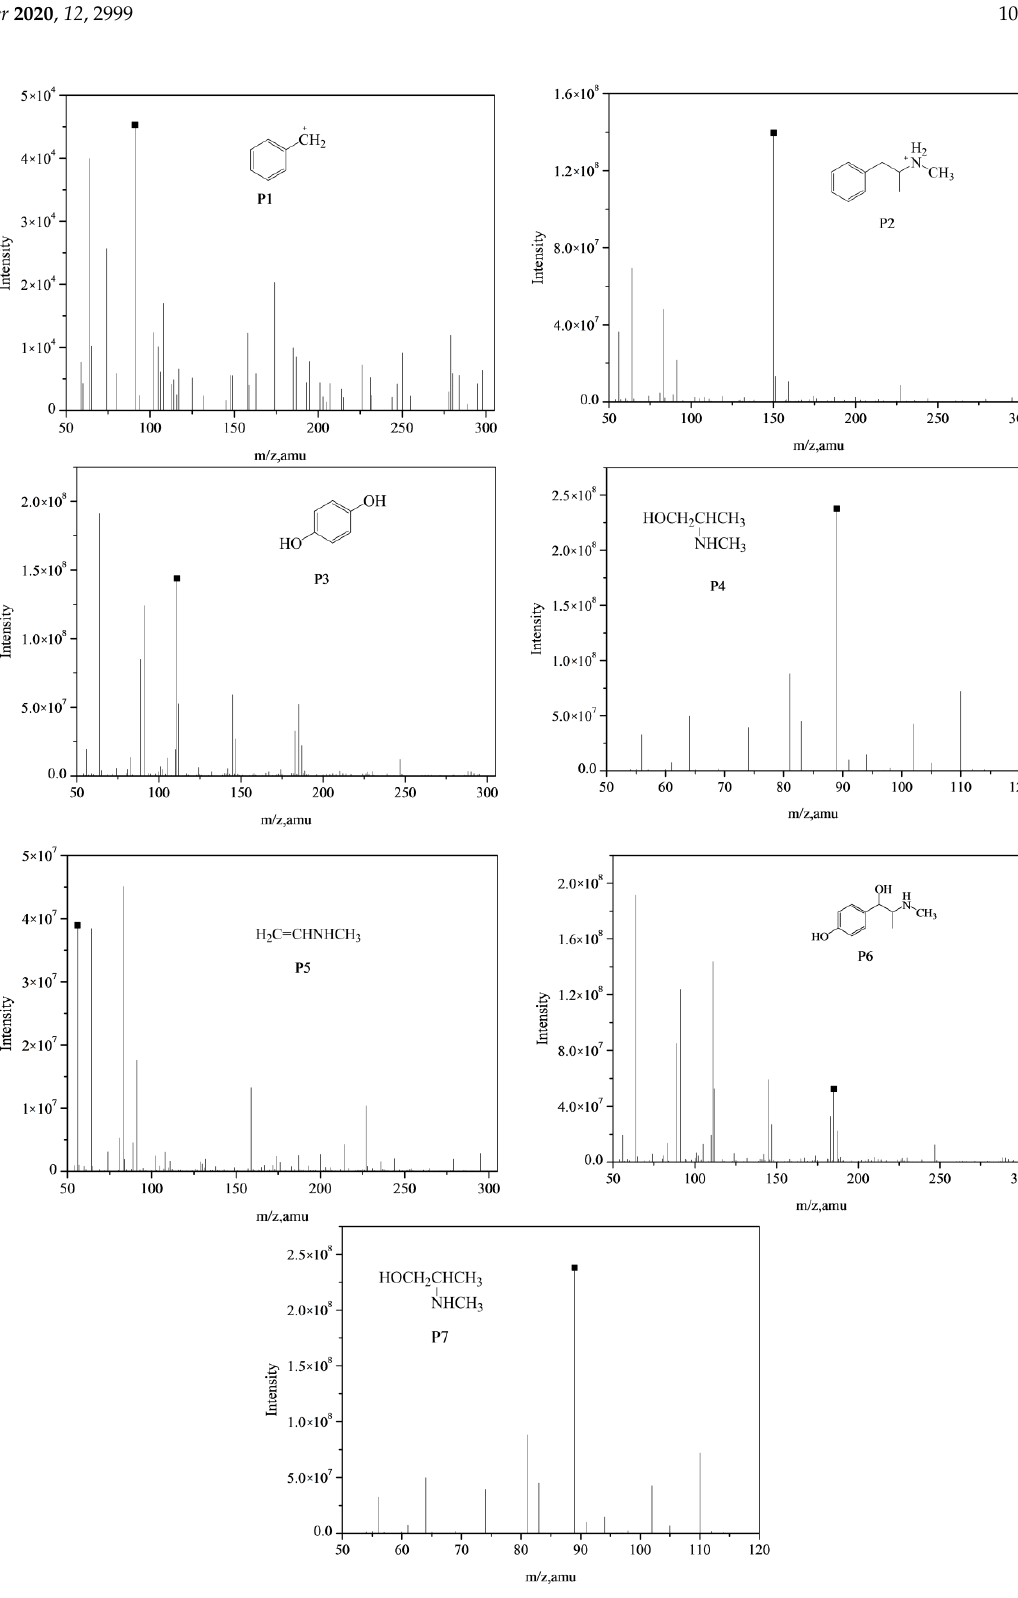
. Figure 11. The ultraviolet–visible spectroscopy of reaction solutions at different concentrations of HA. 3.6. Degradation Products and Mechanism Degradation intermediates and products of METH produced in the UV/H 2 O 2 oxidation process were determined by using UPLC/MS/MS under full scans and product ion scans. During the whole METH degradation process, the mass spectra were compared to identify the intermediates. The